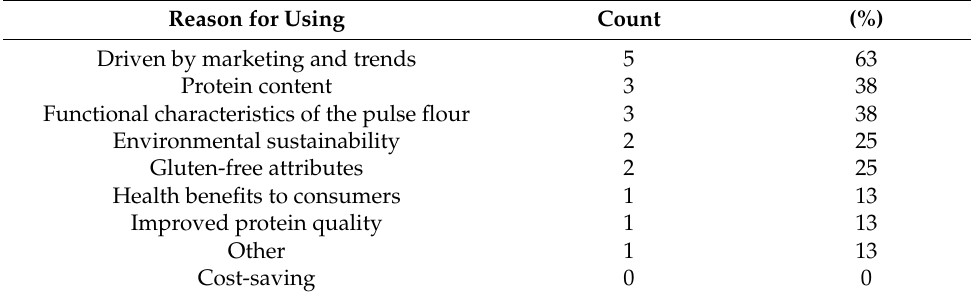
Table 7. Reasons for currently using pulse flours selected by eight current users. Reason for